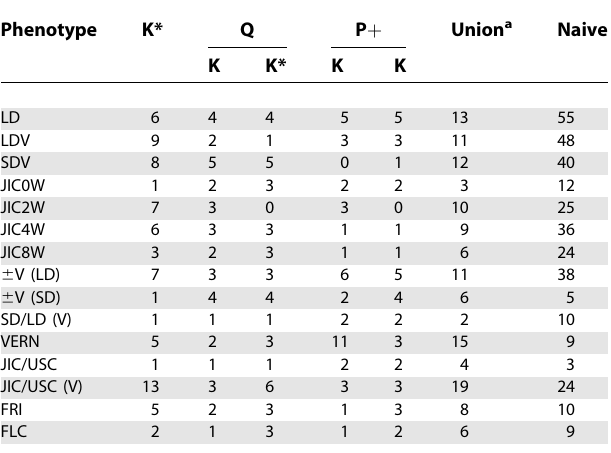
Table 3. Number of Significant Loci at a Nominal 0.1%